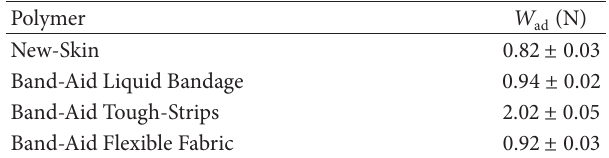
Table 2: Values of work of adhesion ( 𝑊 forming materials or adhesive products. Results are expressed as the mean ± SD for 𝑛 = 8 (replicates)